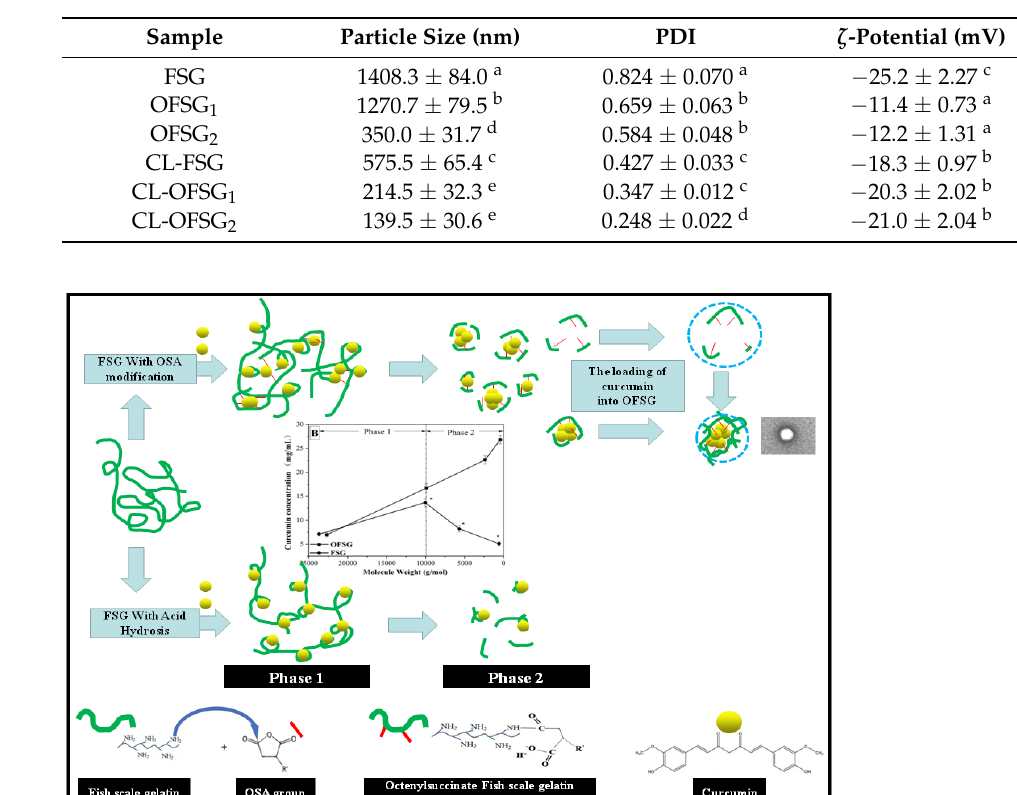
Table 2. Particle size, particle distribution index (PDI) and ζ -potential of fish scale gelatin (FSG) and octenylsuccinate fish scale gelatin (OFSG 1 , degree of substitution = 0.026; OFSG 2 , degree of substitution = 0.107) with (CL-FSG, CL-OFSG 1 ,and CL-OFSG 2 ) or without the loading of curcumin. Values of samples bearing different superscript lowercase letters (a, b, c, d, and e) within the particle size, PDI and ζ -potential are significantly different ( p < 0.05).